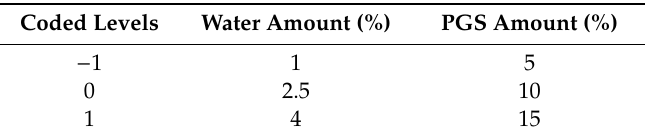
Table 2. The selected levels of independent variables used in design of experiment (DoE). PGS, pregelatinized starch. Coded Levels Water Amount (%)